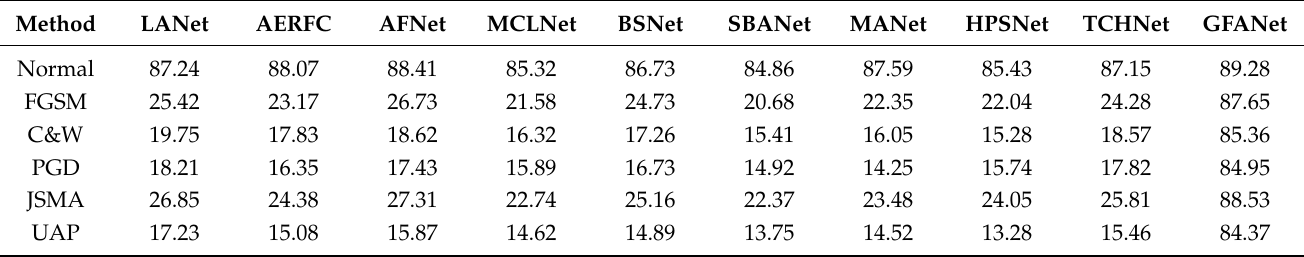
Table 8. Quantitative comparison results on the clean example test sets and the adversarial example test sets generated by different attack methods (reported in